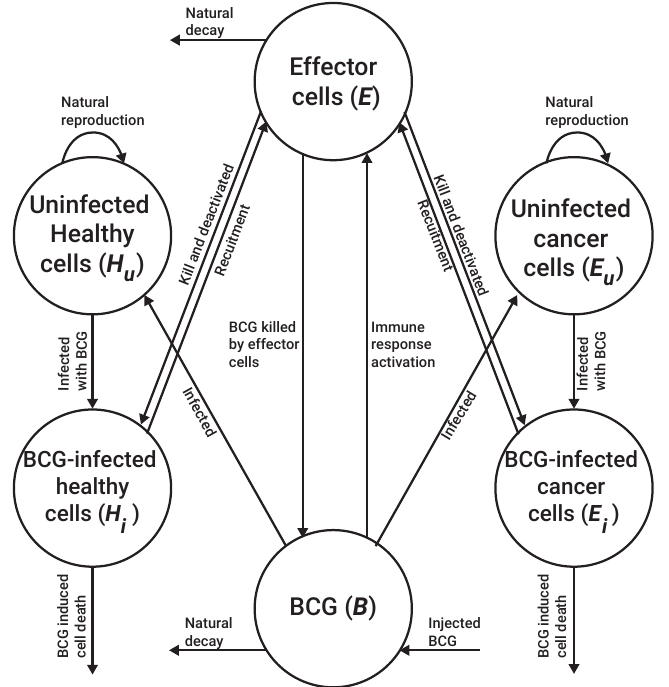
Figure 3. A schematic view of the cell–cell interactions and cell–environment (BCG) interactions in the proposed